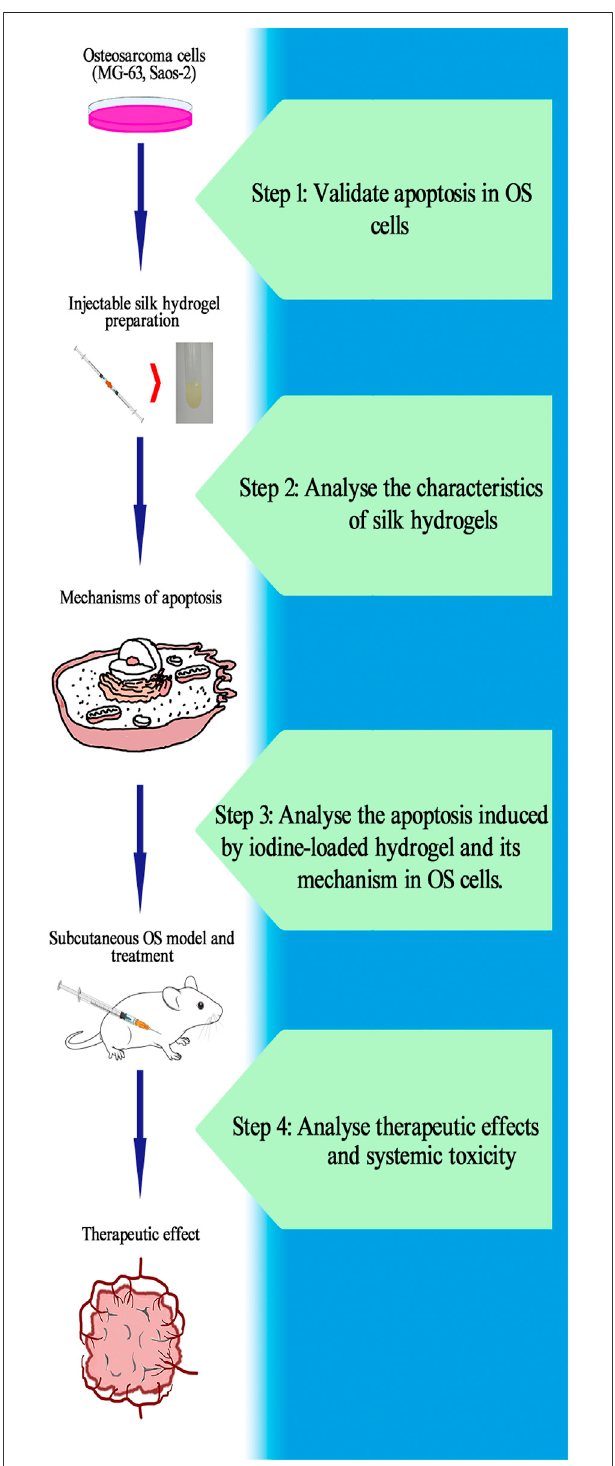
FIGURE1| Idealwork fl owfortheresearchofself-assemblingimageable silk hydrogels. Step 1: Verify the apoptosis induced by iodine in OS cells and calculate the IC 50 . Step 2: Prepare hydrogels and analyse its characteristics. Ensure that the hydrogels can be used as a controlled-release platform for iodine in the treatment of OS. Step 3: After treatment with released iodine